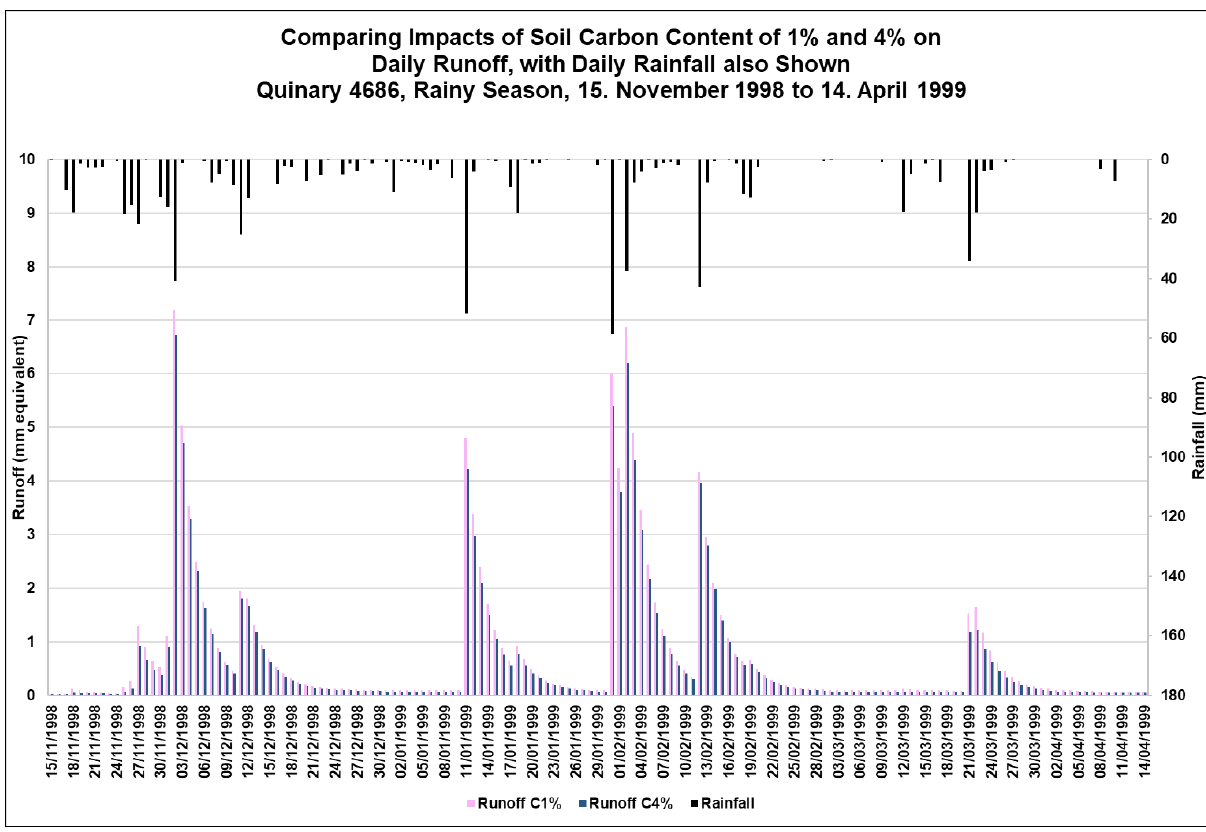
Figure 3: Simulated daily runoff for soil organic carbon of 1% (light pink) and 4% (dark blue), for the Quinary catchment representing Cedara during a 3.5-month period during the rainy season, with daily rainfall shown on the secondary axis.